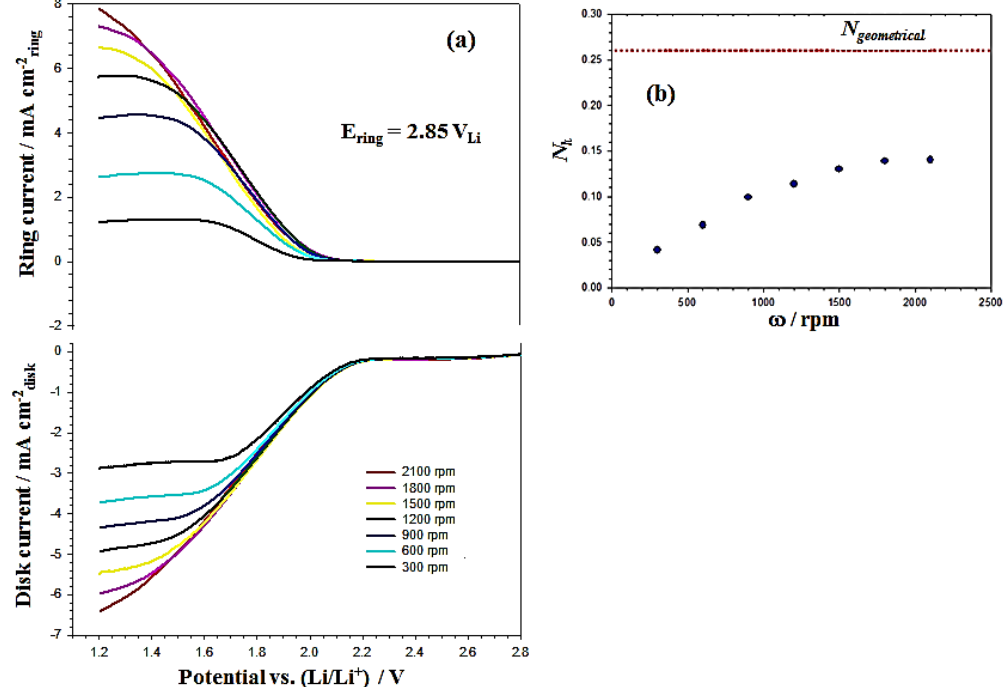
Figure 8. ( a ) RRDE profiles of MnO 2 /C recorded at 50 mV·s − 1 in an O 2 -saturated 0.1 M TBAPF 6 /PC solution, at rotation rates between 300 and 2100 rpm with continuous holding of the Pt ring at 2.85 V Li ; ( b ) evolution of the absolute ratio between the ring and disk current ( N k ) and the electrode rotation speed ( ω ).